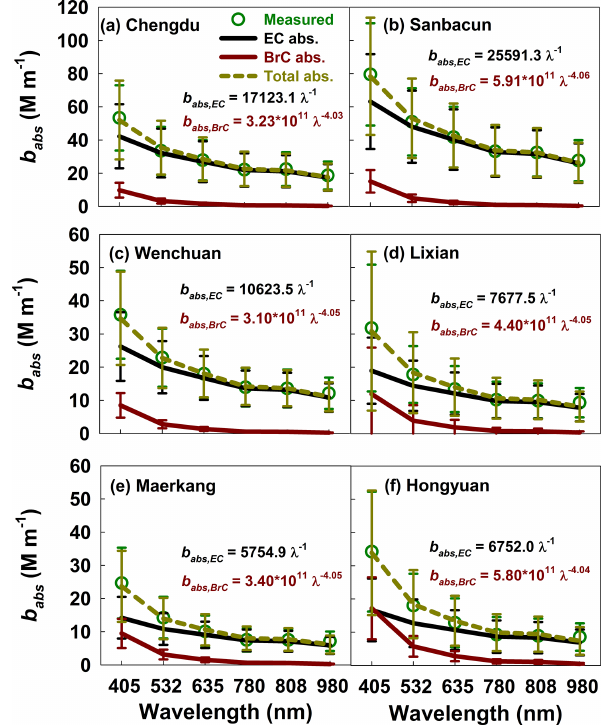
Figure 2. Spectral light absorption coefficients ( b abs ) by EC and BrC in spring and winter at the six sites along the ESTP. The sub- plots depict the decomposition of total light absorption by EC and BrC with the model given in Eq. (4). Error bars represent uncertain- ties derived from replicate analyses and lower quantifiable